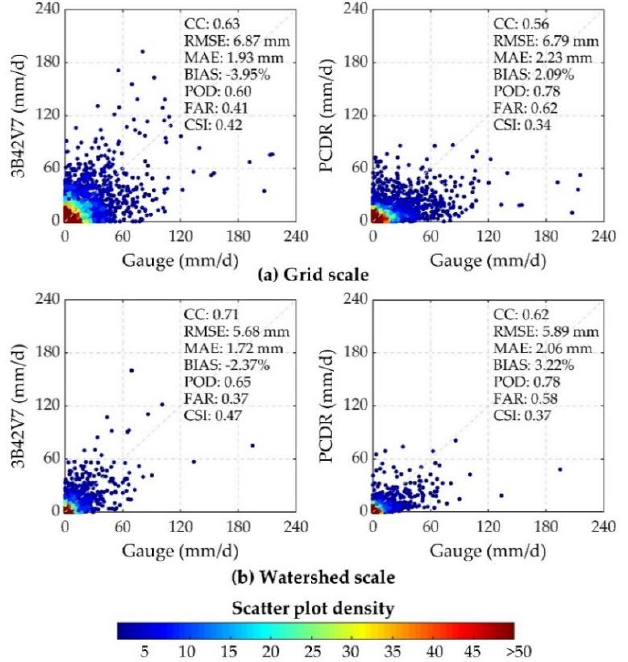
Figure 3. Scatter plots of daily precipitation from 3B42V7 and PCDR versus rain gauges data at the ( a ) grid scale and ( b ) watershed scale.